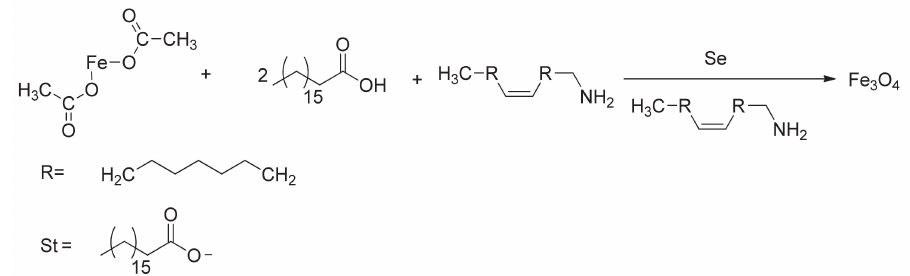
Scheme 3. Plausible reaction scheme for the synthesis of Fe 3 O 4 from Fe(Ac) 2 and OLA. It should be noted that OLA shows on the arrow refer to the solvent for preparing the Se